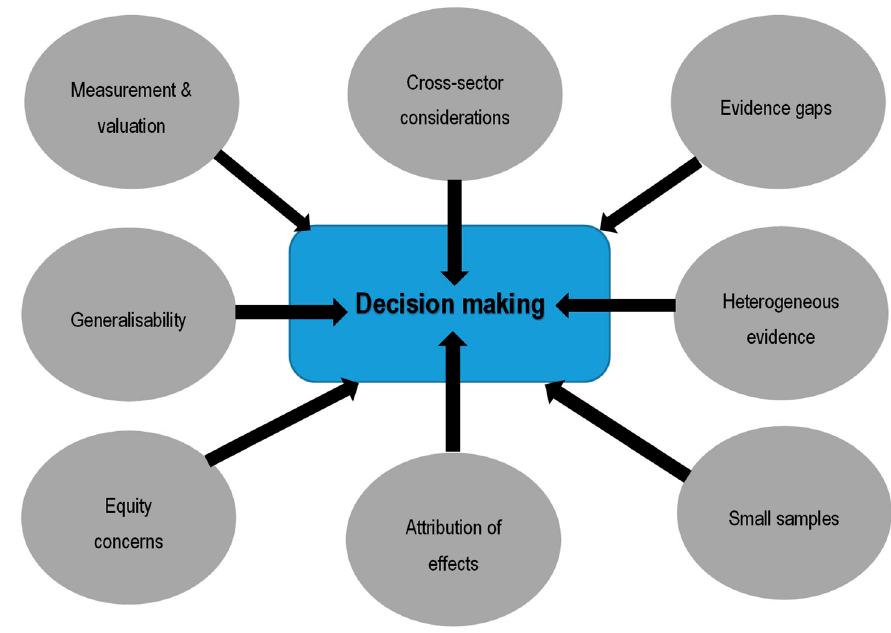
Figure 1. Schematic of challenges in the evaluation of public health interventions.